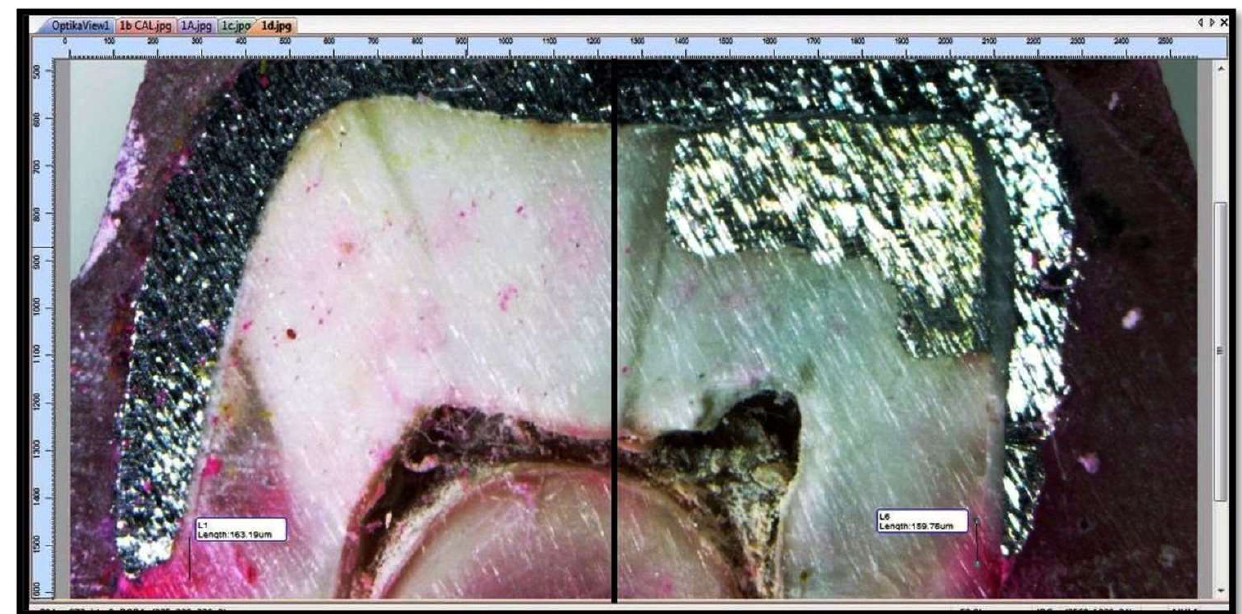
Figure 4. The tooth half with restoration was the experimental side; the other half served as the control (Each sample was studied by diving into facial part marked as F and the lingual part as L. Each F and L part were divided into a right and left half for the digitizing process. The sample half (divided by a line at the centre) with restoration (amalgam or composite) was considered as experimental half and other half was marked as control.